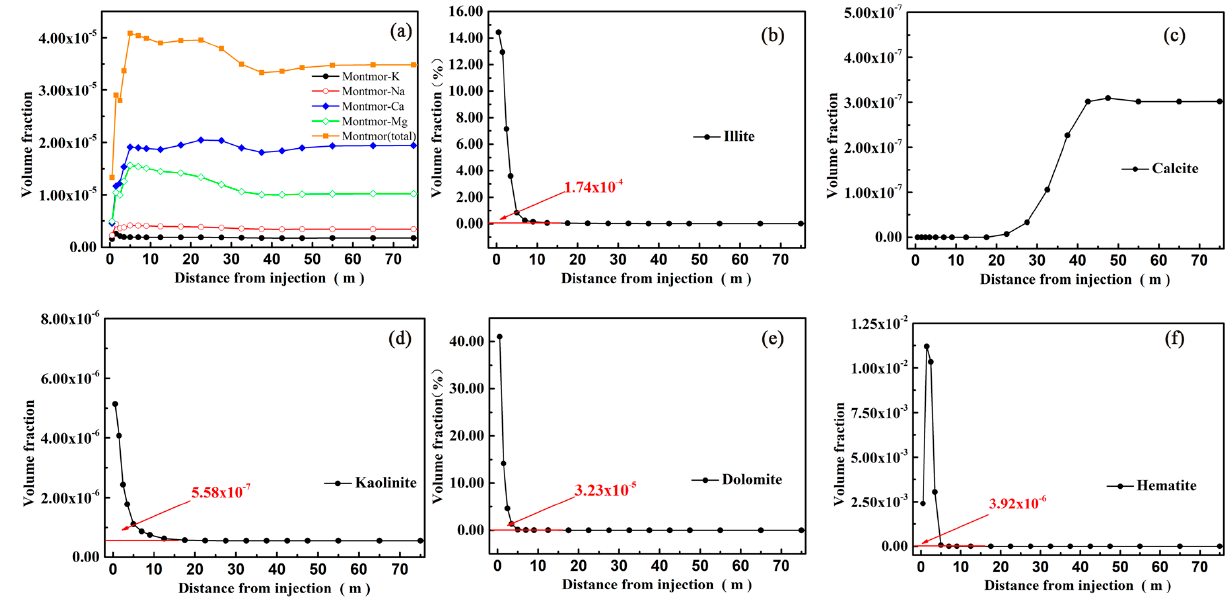
Figure 5. Precipitation of secondary minerals. ( a )—Montmorillonite; ( b )—Illite; ( c )—Calcite; ( d )— Kaolinite; ( e )—Dolomite; ( f )—Hematite.